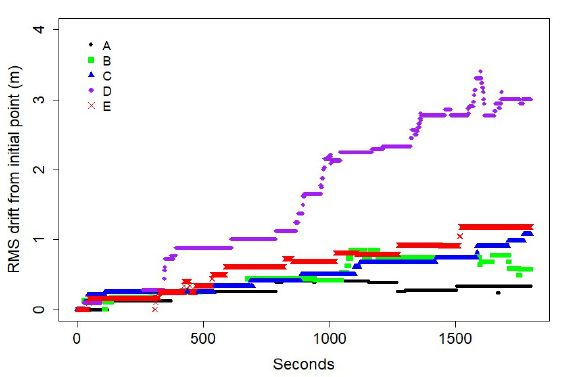
Figure 10. RMS error increases over time with respect to drift from the first data point in the sequence.